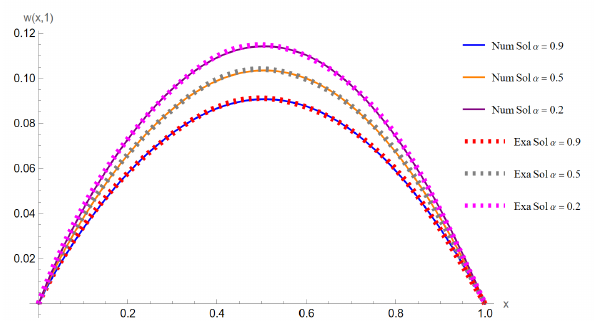
Figure 3. The analytical and numerical solution of (36) for different α = 0.2,0.5,0.9, β = 1.9 and t = T =